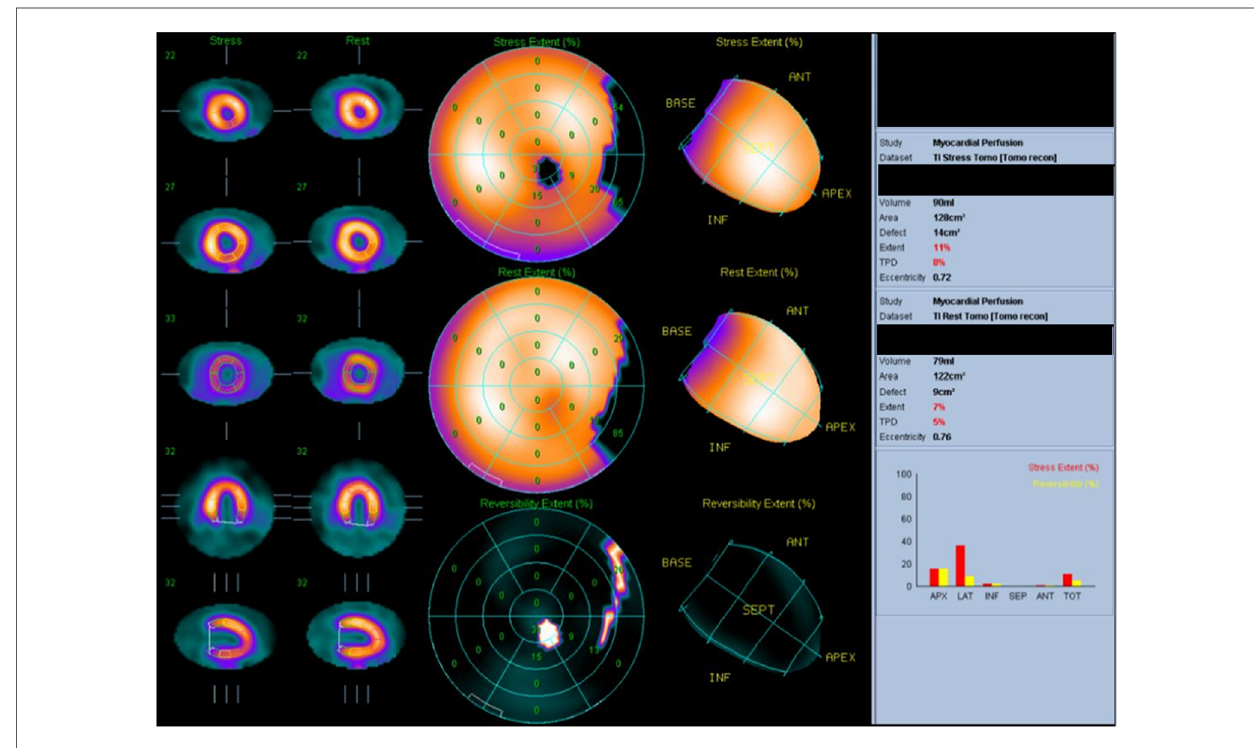
FIGURE 2 Thallium-201 myocardial perfusion: transient ischemic dilatation and old myocardial infarction of the left circum fl ex